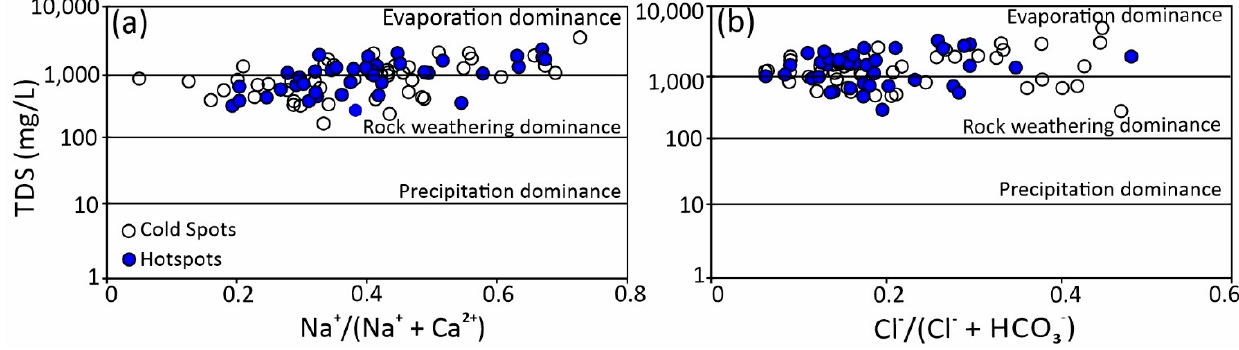
Figure 2. Gibbs plot for groundwater samples: ( a ) TDS vs. Na + / (Na + + Ca 2+ ); ( b ) TDS vs. Cl − /(Cl − + HCO 3 − ).